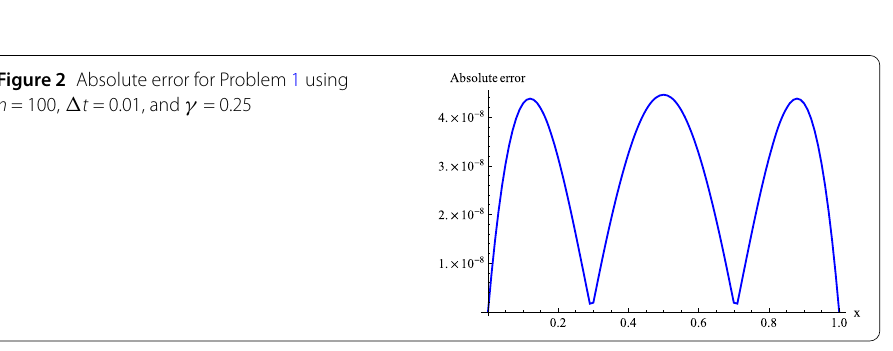
exhibits a good agreement with the theoretical estimation. In Fig. 1, three-dimensional visuals of exact and approximate solutions are displayed for n = 100, (cid:12) t = 0.01. The abso- lute numerical error at t = 1 corresponding to n = 100, (cid:12) t = 0.01, and γ = 0.5 is portrayed in Fig.